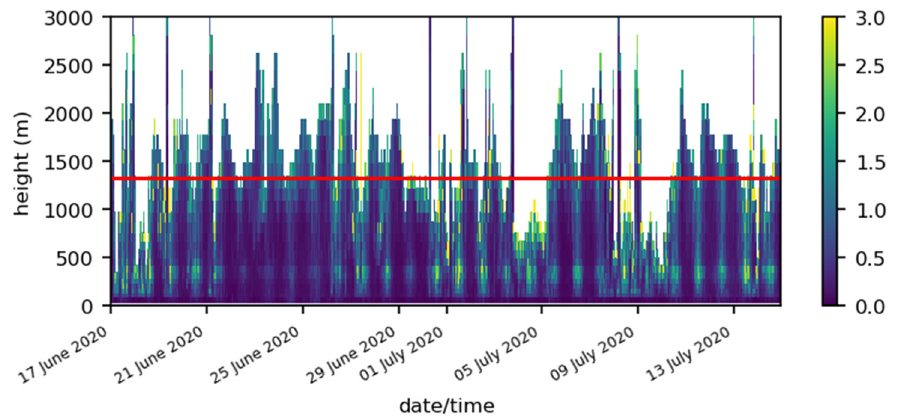
Figure 19. Time height cross section for the full period of the BB-DIAL estimated uncertainty. The horizontal red line is the average height.